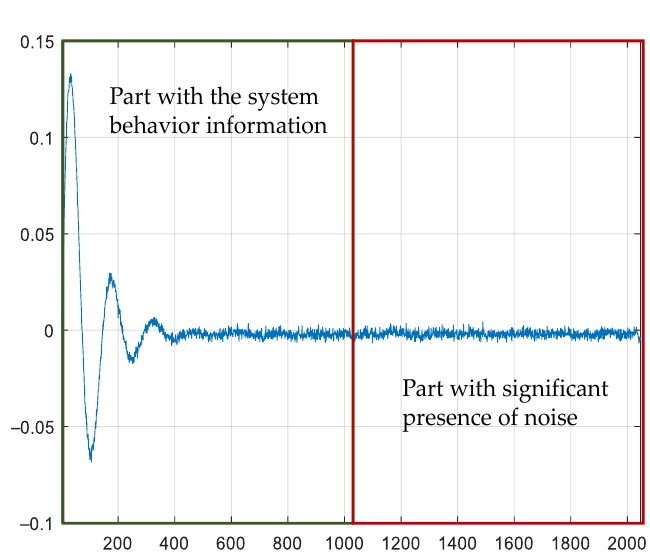
Figure 2. Impulse response with two different areas of information.